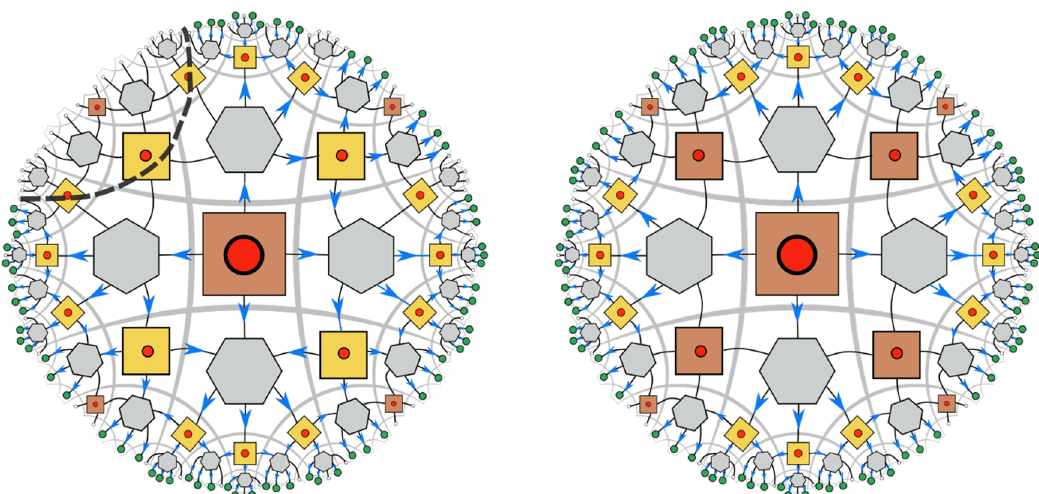
Figure 36. Inserting SBSTs sparsely into the tensor network can still allow operators to be pushed to the boundary independently. Therefore, each bulk qubit can be accessed independently from the boundary. However, more SBST imposes more obstruction for pushing. Left: operator can be pushed to a boundary subregion. Right: the operator can be accessed globally, but not in the previous subregion. The pushing assumes SBSTs are intialized in non-zero logical